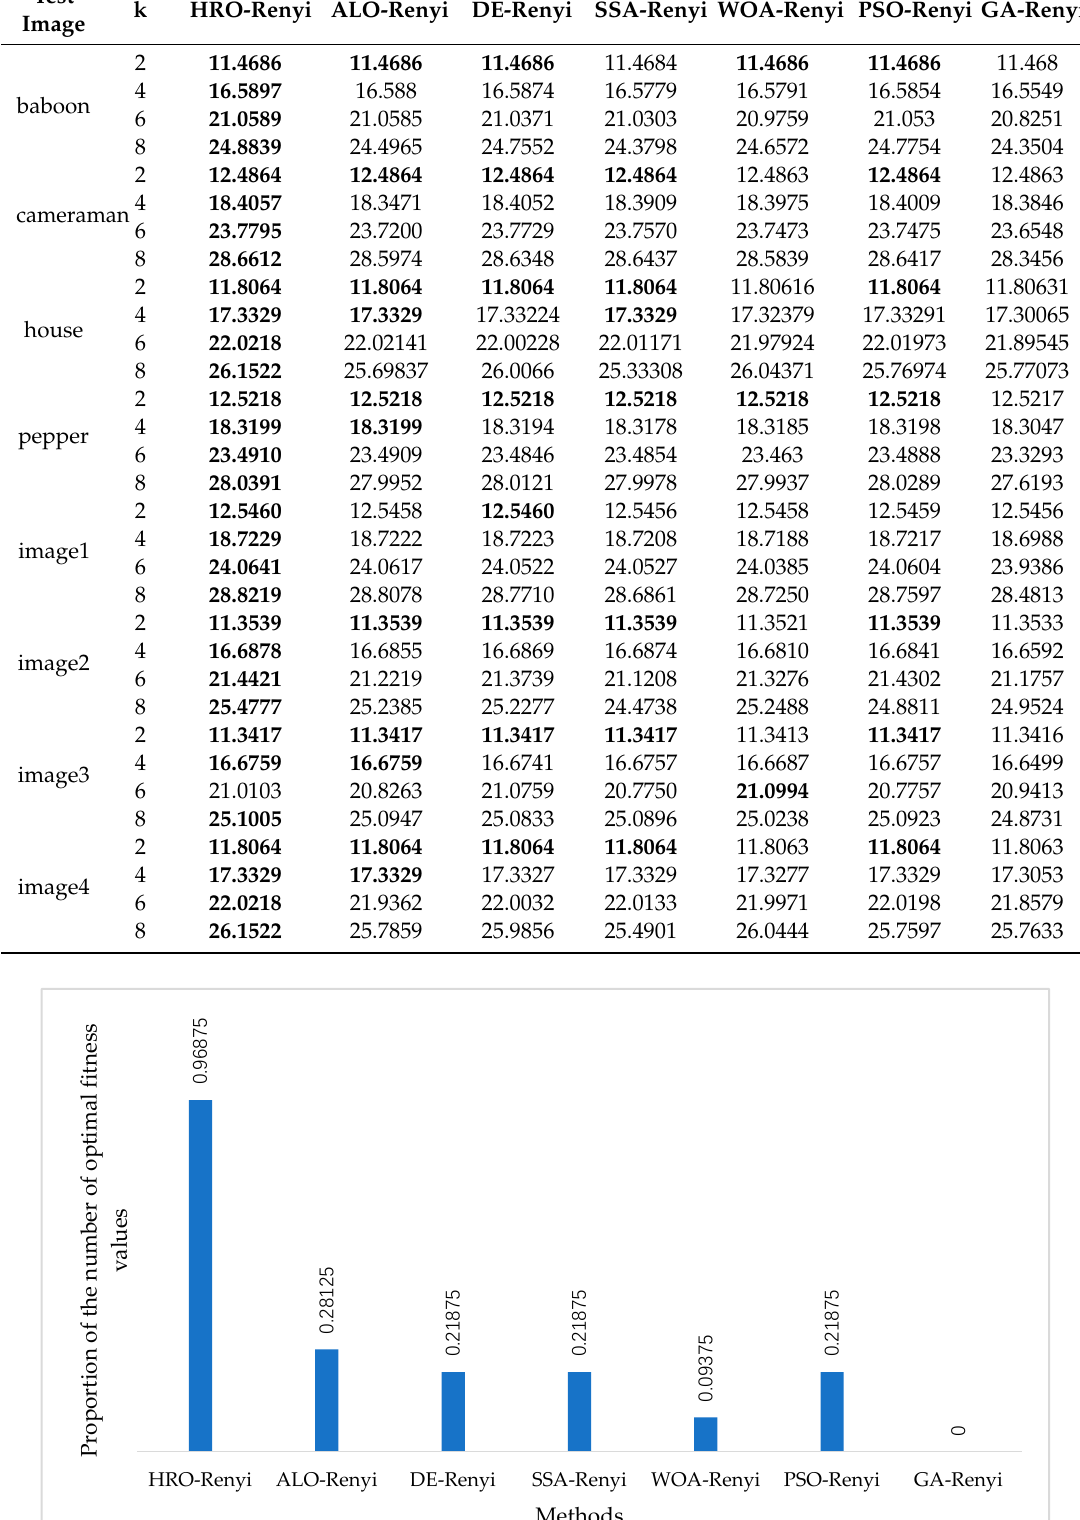
Table 2. The average fitness values of each algorithm under Renyi’s entropy.